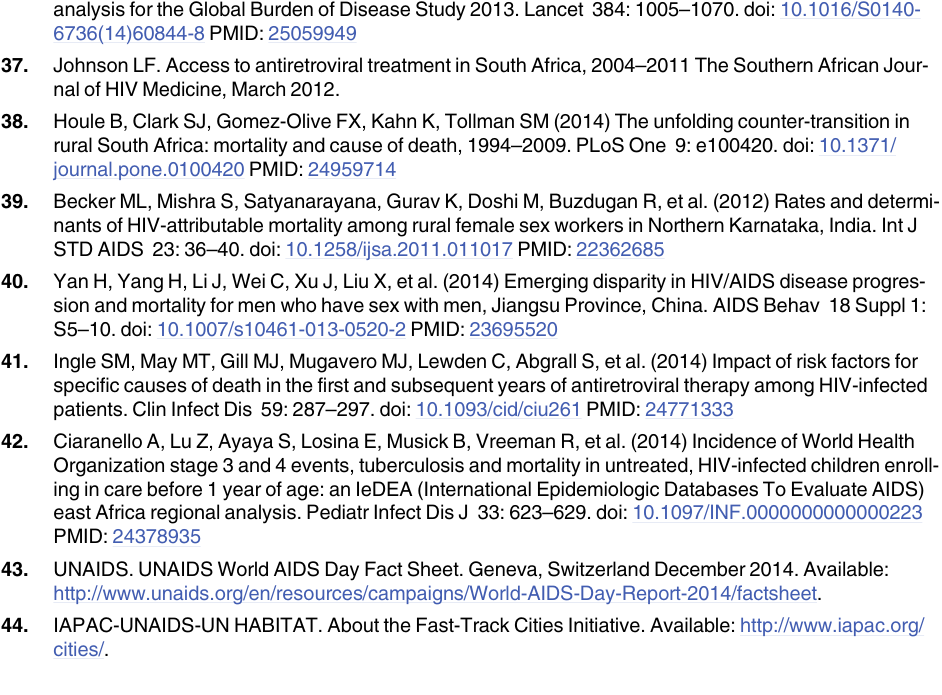
PLOS ONE | DOI:10.1371/journal.pone.0131353 July 6,